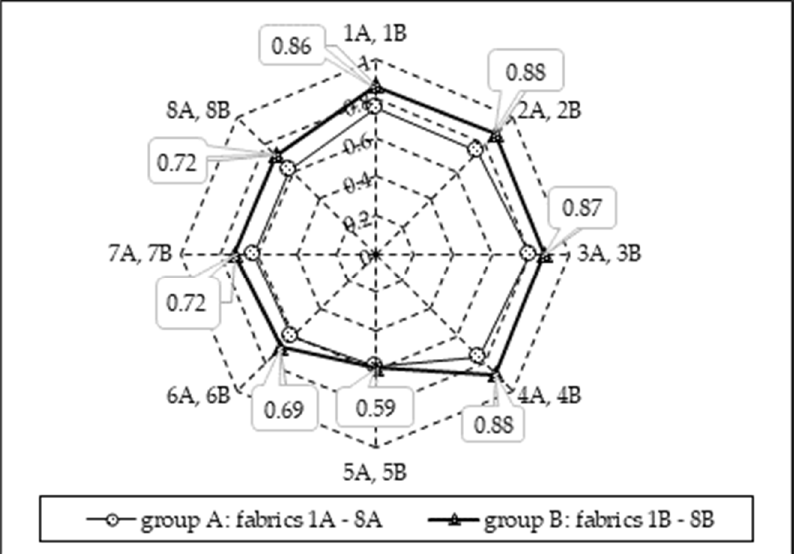
Figure 9. Overall moisture management capacity (OMMC) of the fabrics tested .